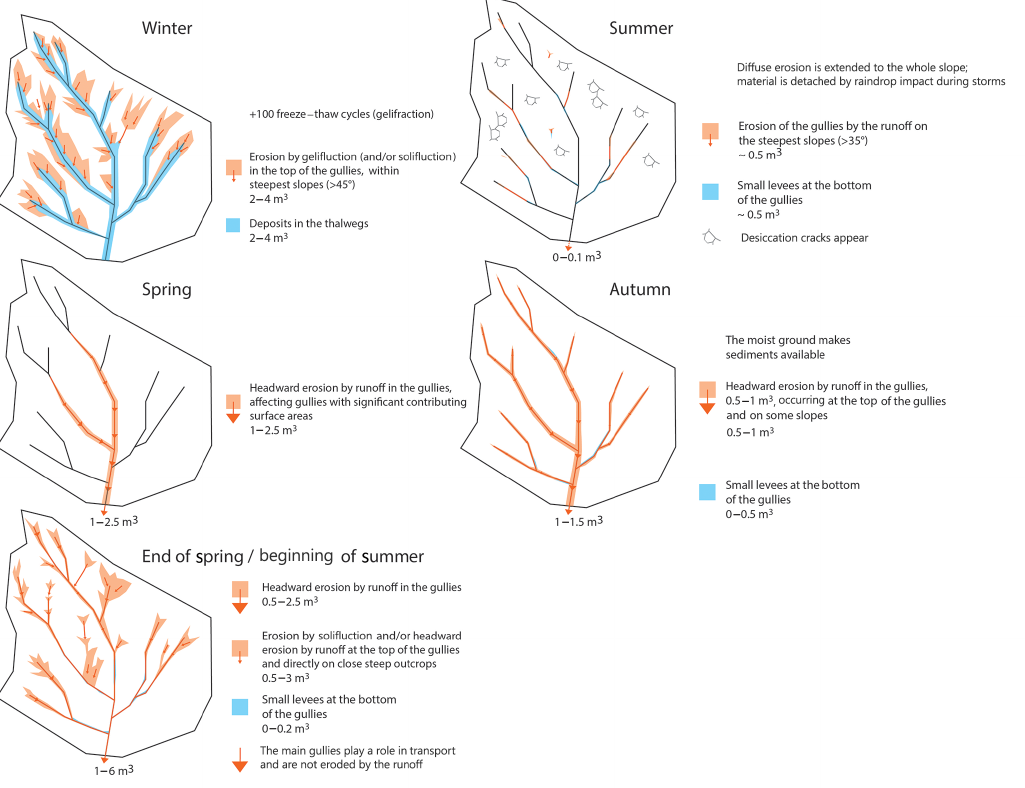
Figure 8. Conceptual model describing the seasonal pattern of erosion and deposition and quantification of the volumes of sediment transfer at La Roubine